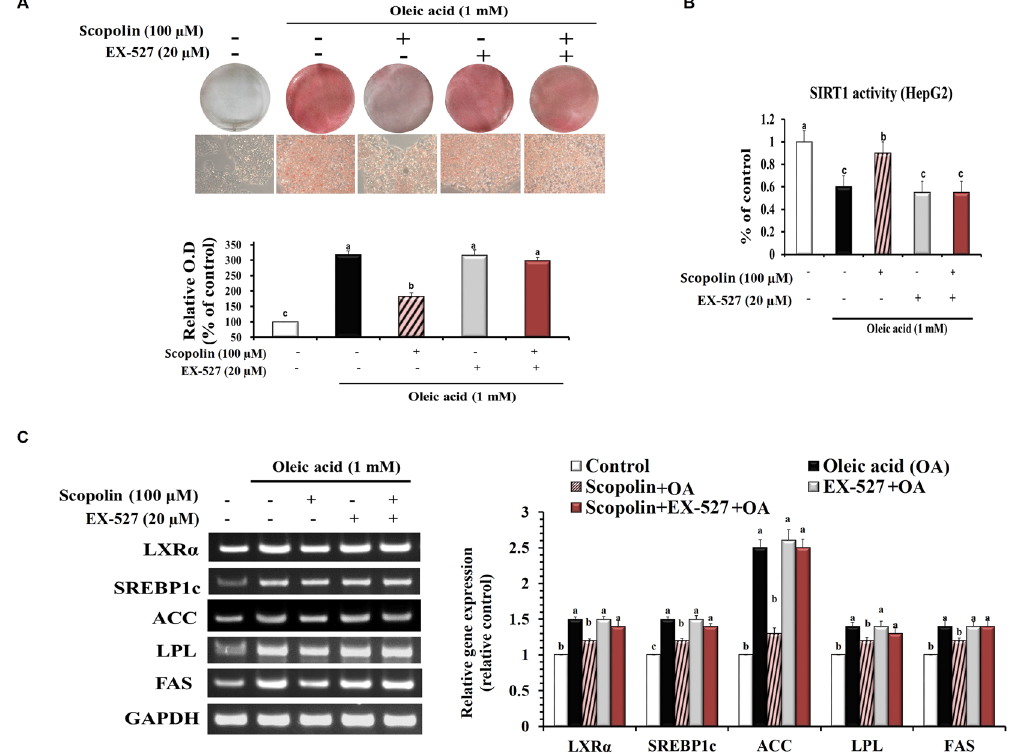
Figure 2. Scopolin exerts its anti-lipogenic activity via SIRT1 in HepG2 cells. Cells were exposed to oleic acid (1 mM), scopolin (100 μ M), and SIRT1-specific inhibitor EX-527 (20 μ M) for 24 hr. ( A ) Oil-Red O staining of cells with different treatments. Images are representative of at least three independent experiments. Original magnification 400x. ( B ) Catalytic activity of SIRT1 in HepG2 cells. ( C ) The expression of lipogenic-related genes was determined by RT-PCR and normalized to that of GAPDH. The full-length gels are presented in Supplementary Fig 1. Data means from three independent experiments. Different letters indicate statistical significance, p <